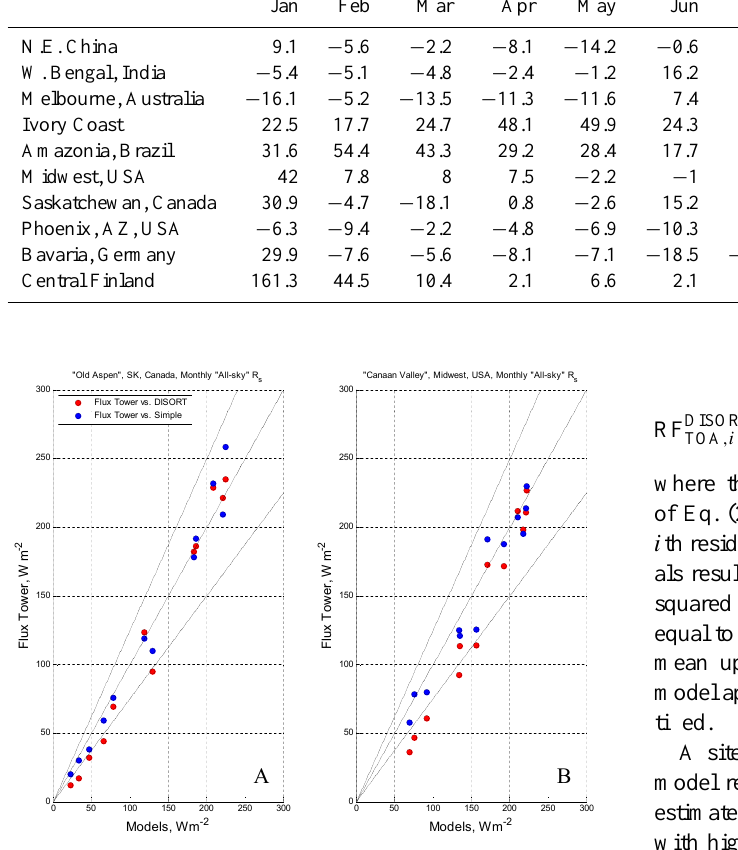
Fig. 2. Modeled vs. observed monthly mean “All-sky” R s for the two case study regions: (A) “Saskatchewan, Canada” and (B) “Mid- west USA”. Observed R s data for each case region are based on the “Old Aspen” flux tower site located at 53.2 ◦ N, − 106.2 ◦ W Barr and Black, 2013) and the “Canaan Valley” flux tower site located at 39.1 ◦ N, − 79.4 ◦ W (Meyers, 2013), respectively.